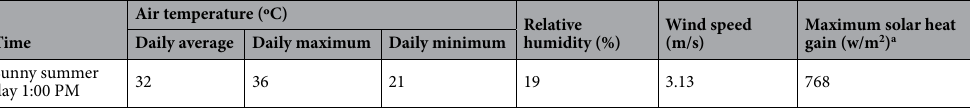
Table 2. Environment weather conditions in the time of experiments. a Obtained by Carrier software.